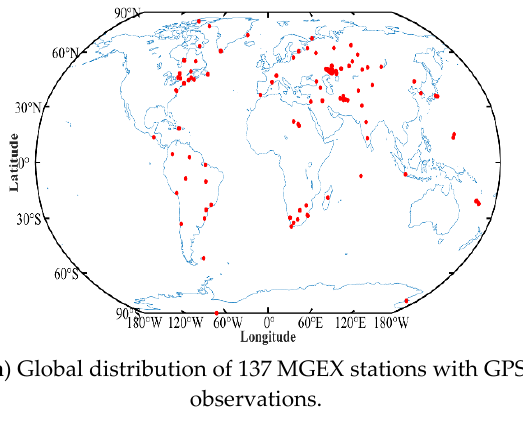
Figure 1. Global distribution of ( a ) 137 MGEX stations with GPS observations and ( b ) 232 MGEX stations with BDS observations.